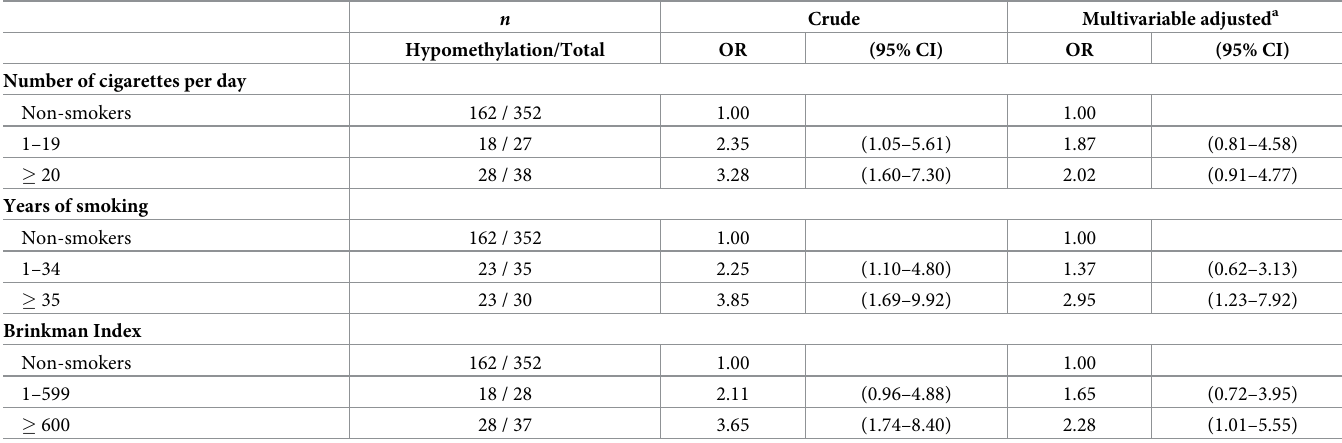
Table 4. Odds ratios (ORs) and 95% CIs for hypomethylation of the TXNIP gene according to smoking status.